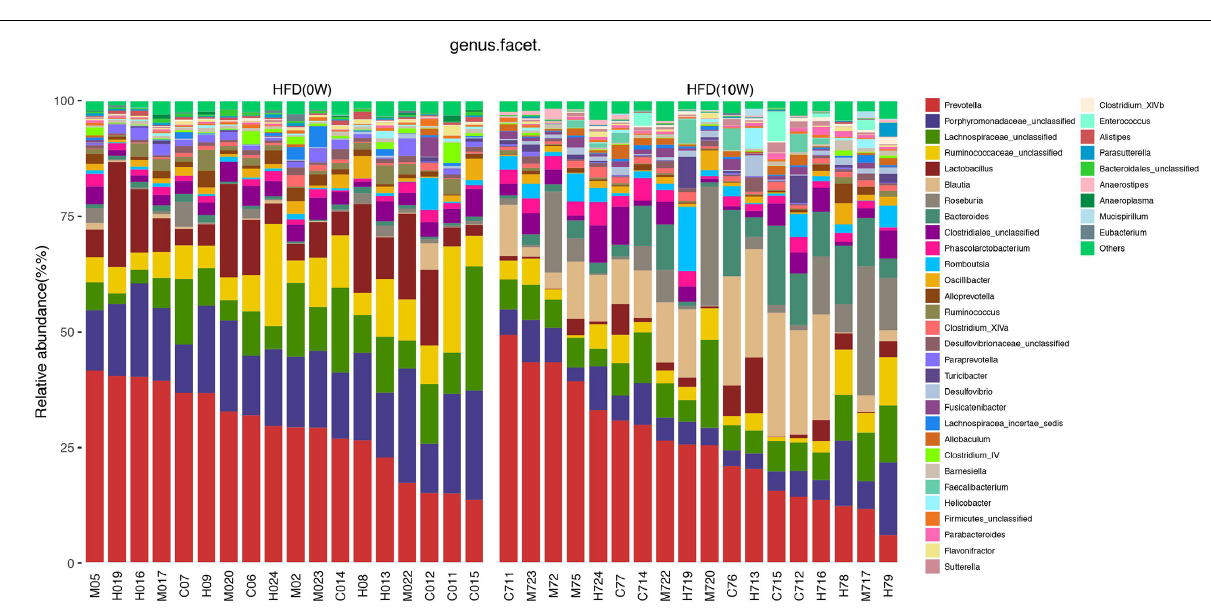
FIGURE 7 | Responses of the structure of the gut microbiota to HFD at the genus